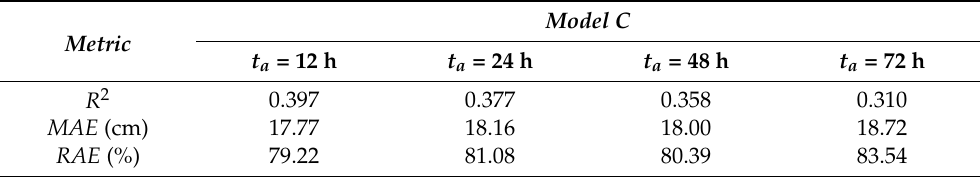
Figure A3. Extreme storm tide event forecasting for the period 11–14 November 2019, comparison between measured time series and predicted values: Model C. Table A2. Forecasting performance—Model C.